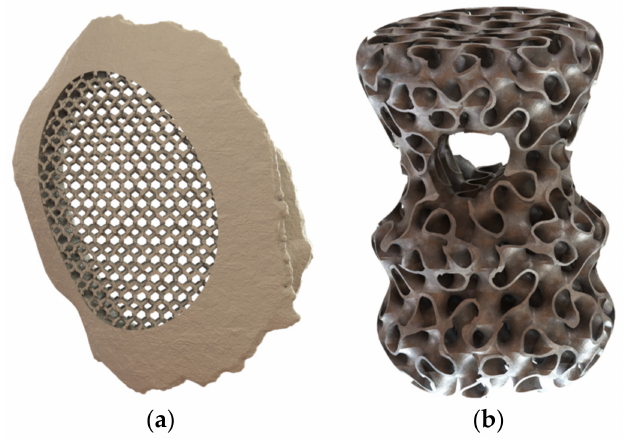
Figure 3. Constant size and relative density generated lattice structure for ( a ) skull implant partially filled with a cubic diamond lattice structure and ( b ) spline-based revolved artifact-filled